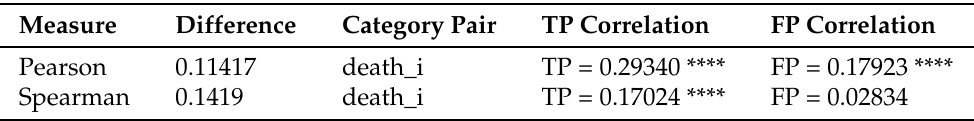
Table 15. Death and 1st person singular in